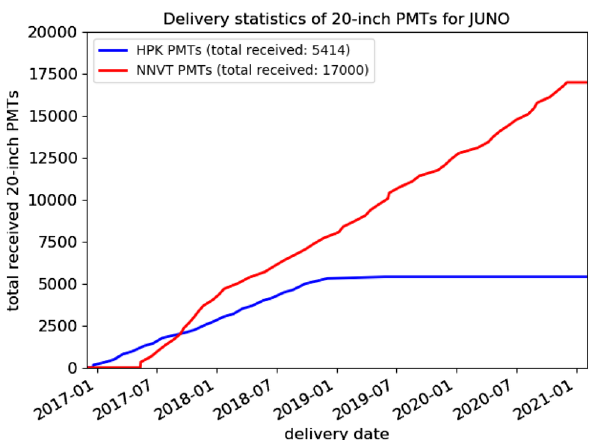
Fig. 5 Statistics of PMTs received at Zhongshan Pan-Asia 20-inch PMT testing and potting station and later tested within the testing sys- tems. In total 22,414 PMTs were delivered